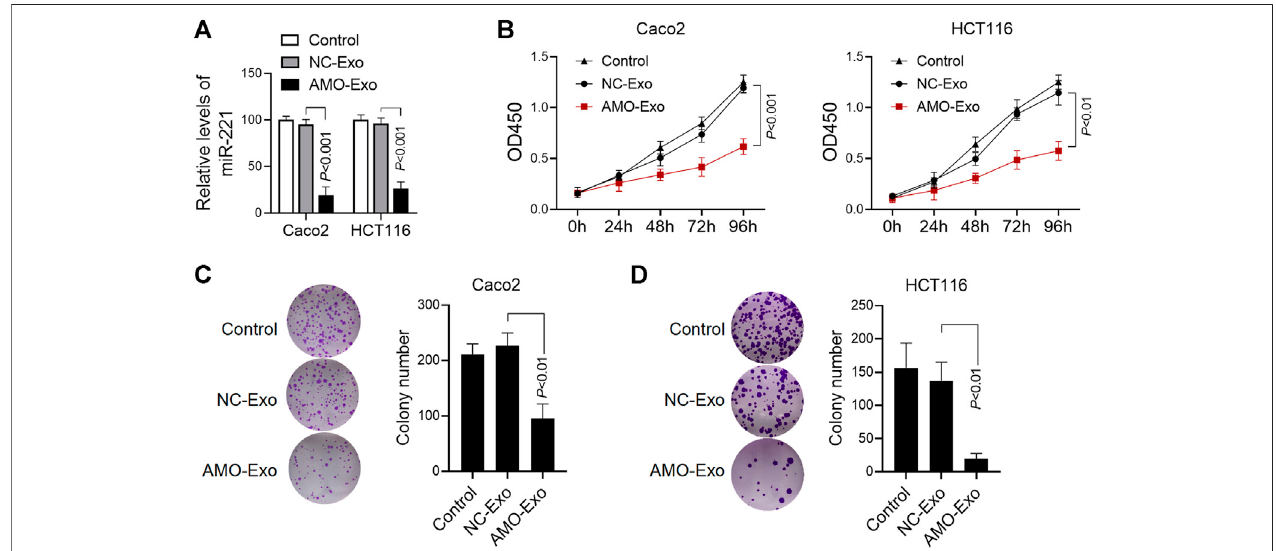
FIGURE 3 | AMO-loaded exosomes inhibited colon cancer cell proliferation. (A) The relative expression level of miR-221 in colon cancer cells was detected by Q-PCR. Caco2 and HCT116 cells were treated with 20 μ g exosomes containing anti-miRNA-221 (AMO-Exos) or their controls (AMO-NCs) for 24 h, and then lysed to detect the expression level of miR-221. (B) Caco2 and HCT116 cells were treated with 20 μ g exosome drugs. After continuous culture for different times, the cell proliferationwasevaluated. (C) EffectofexosomedrugsoncloneformationabilityofCaco2cells.Caco2cellsweretreatedwith20 μ gexosomedrugsandcultured for 14 days. The number of clones was calculated and histograms were shown. (D) Effect of exosome drugs on HCT116 cell clone formation ability.